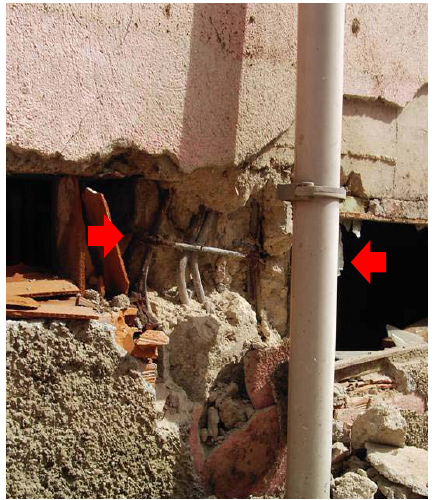
Figure 10. Short column and non-ductile column